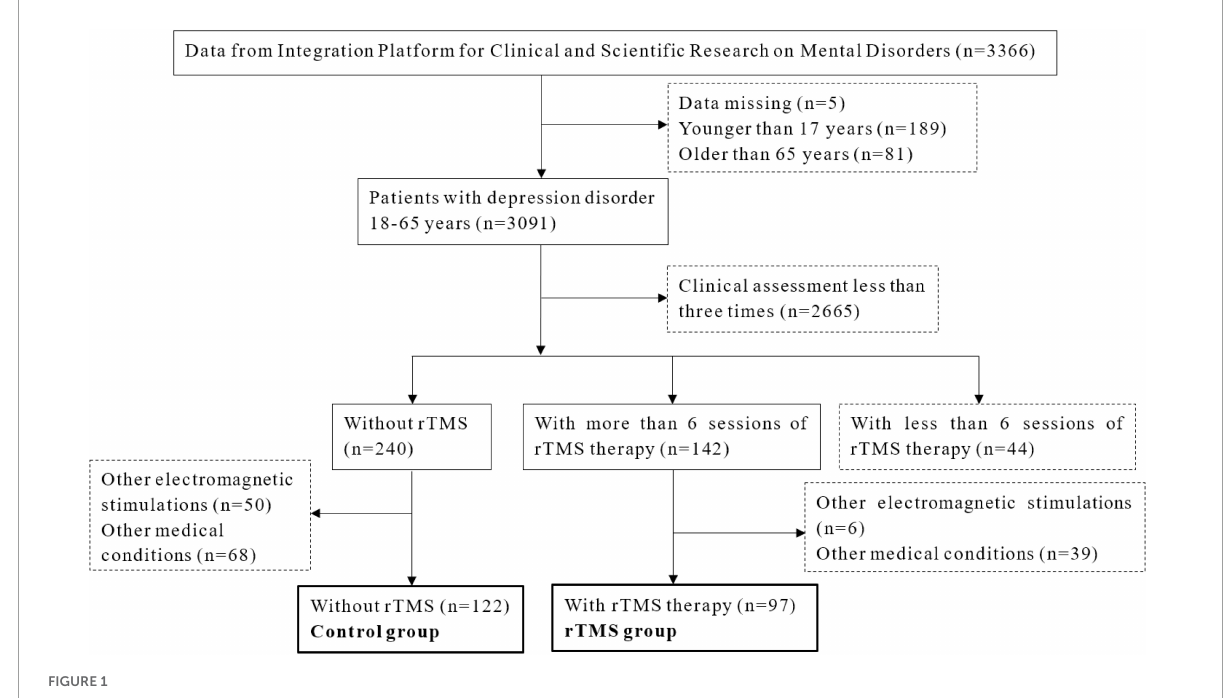
FIGURE1 Flow diagram of the